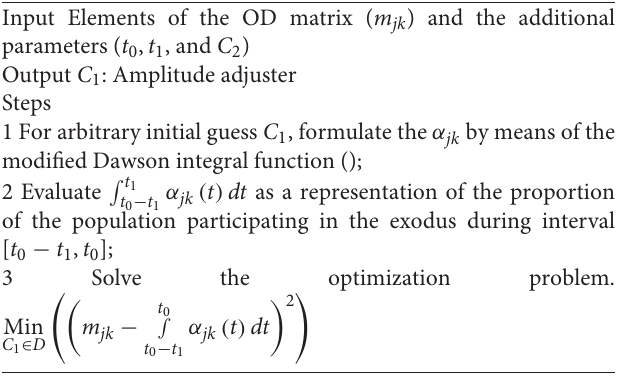
Algorithm 1 : Estimating C 1 given the information from the OD matrix and three additional